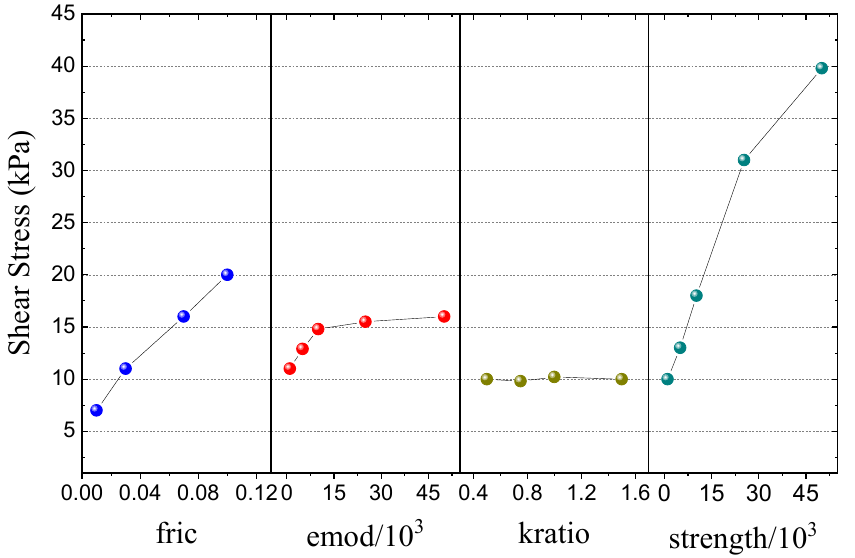
Figure 4. Influence of microscopic parameters on shear stress.